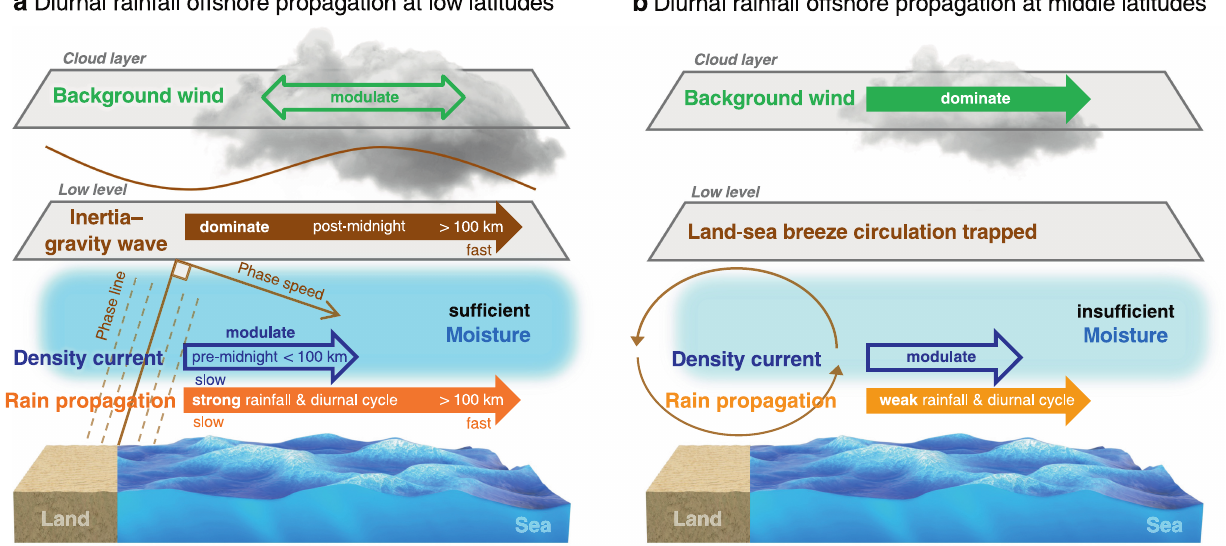
Fig. 5 | Conceptualmodelofdiurnalrainfall offshore propagation(OP). a OPat lowlatitudesinahigh-moistureenvironmentischaracterisedbystrongrainfalland diurnal cycle, and is mainly caused by inertia – gravity waves forced by the terrain/